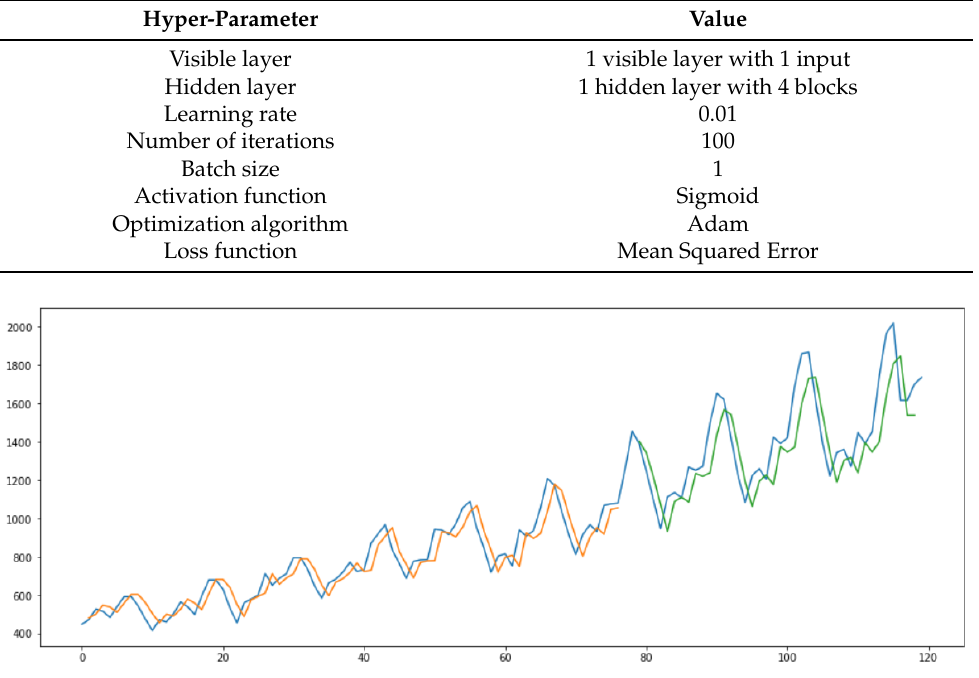
Table 2. The hyper-parameter value of LSTM model.